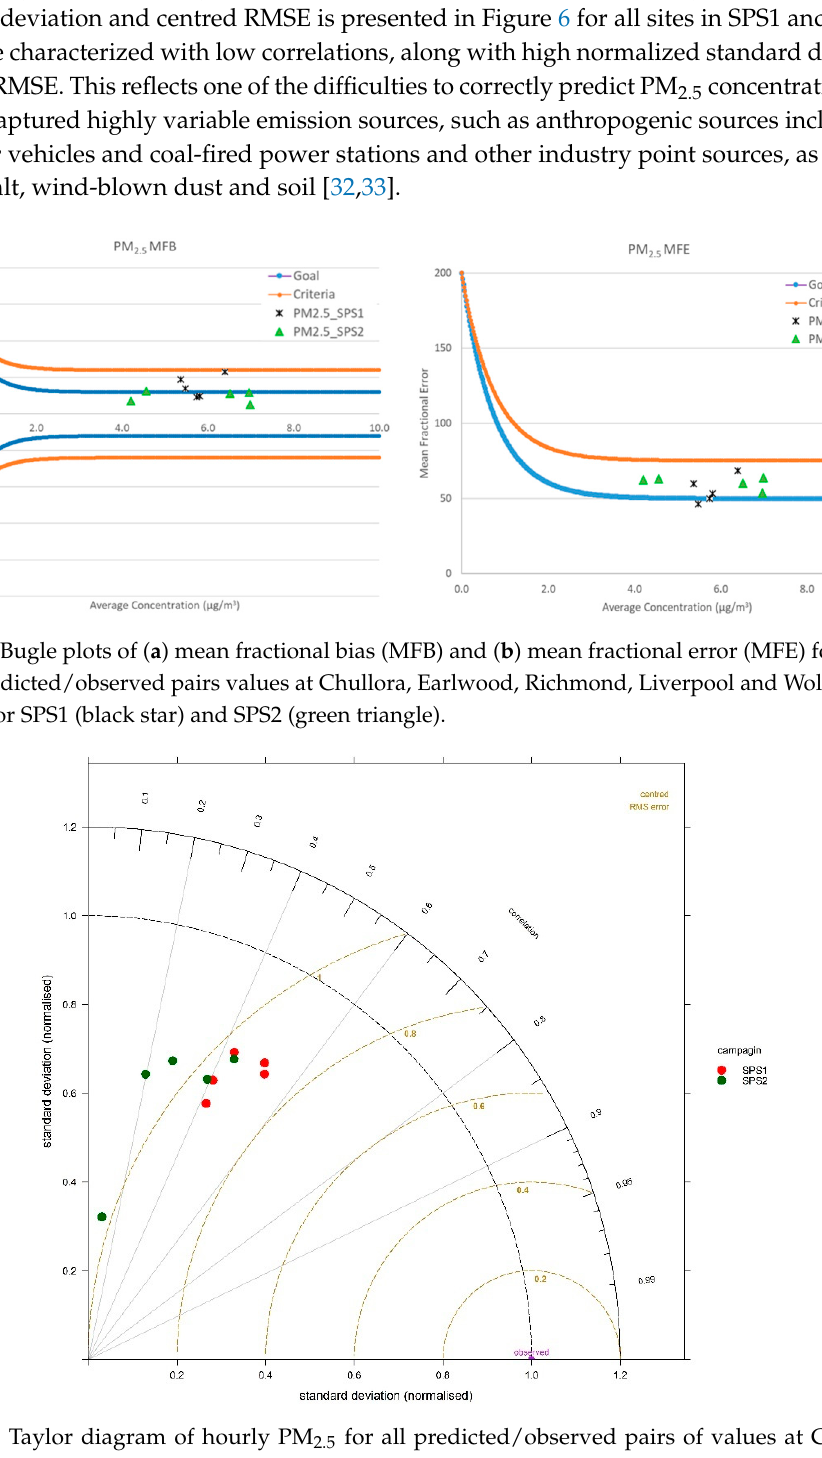
Figure 6. Taylor diagram of hourly PM 2.5 for all predicted/observed pairs of values at Chullora, Earlwood, Richmond, Liverpool and Wollongong stations for SPS1 (red dot) and SPS2 (green dot).